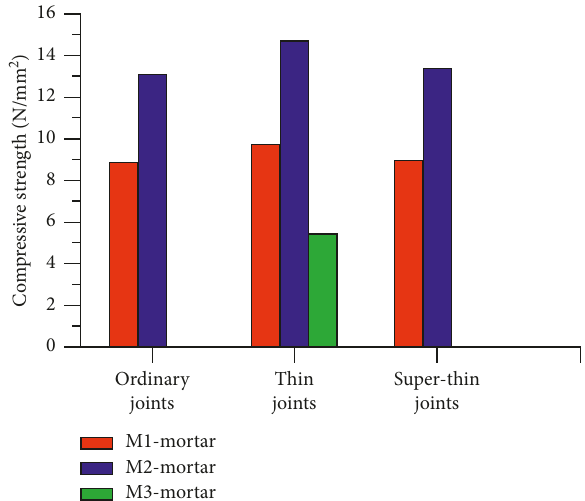
Figure 7: Values of the compressive strength as function of the bonding material and the joints.